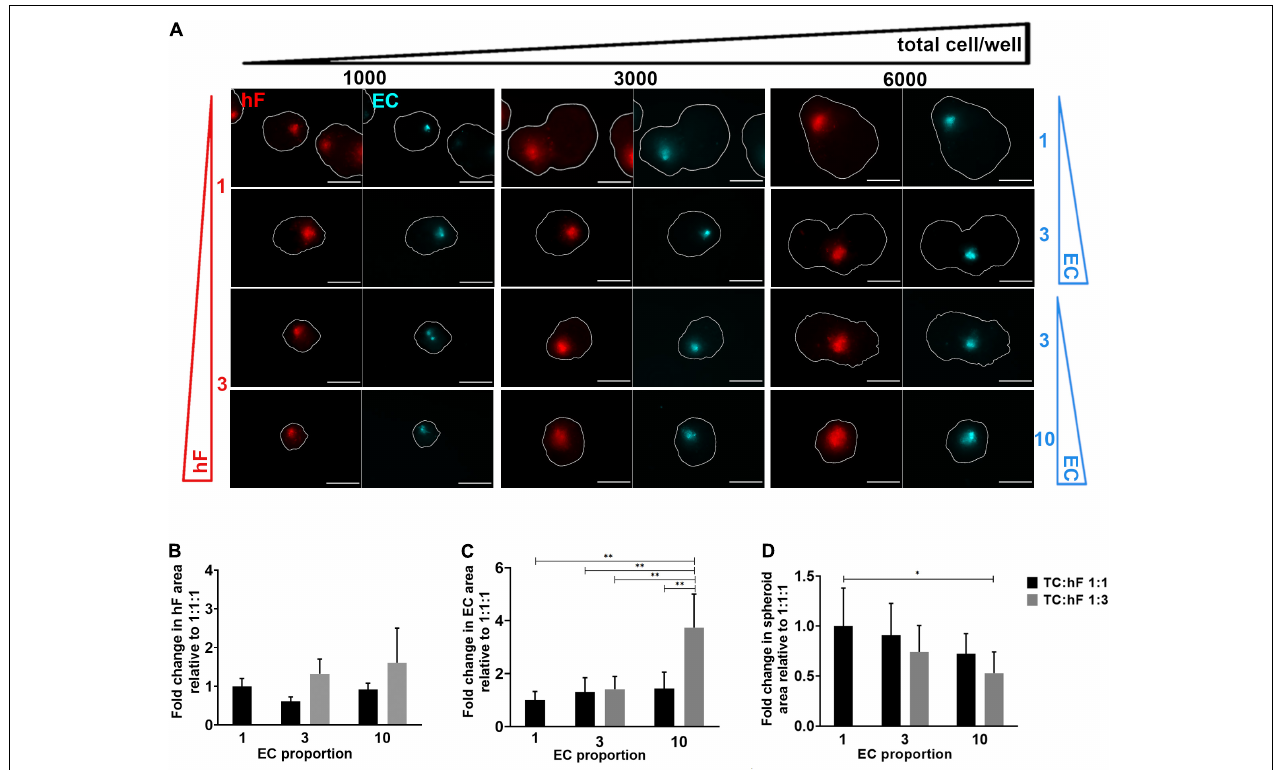
FIGURE 2 | Fibroblast and endothelial cell content in triple heterotypic spheroids: effect of total cell number and cell ratio. (A) Fluorescence microscopy of spheroids at day 30 of culture (after 2 days of static culture followed by 28 days of agitation-based culture). Spheroids of HCC1954 breast tumor cells (TC); human dermal fibroblasts, labeled with PKH26 (hF, red); HUVEC, labeled with CellTracker Deep Red (EC, cyan), seeded at the TC:hF:EC ratios and cells per well indicated. The spheroid outline at the equatorial axis is represented in a solid white line and was determined based on the FDA labeling of live cells ( Supplementary Figure 3A ). Images are representative of the 5–10 spheroids assessed per condition, in each of the three to four independent experiments performed. Scale bar, 250 µ m. Quantification of fold change in (B) hF area, (C) EC area, and (D) total spheroid area at the equatorial axis, for spheroids from A, seeded at 6,000 cells per well. The EC and hF areas were normalized for the total spheroid area at the equatorial axis; the fold change was determined relative to the condition with a TC:hF:EC of 1:1:1. Data are presented as mean ± SD from N = 3–4 (independent experiments); in each experiment, at least 20 spheroids were quantified per condition; statistical analysis was performed using a one-way ANOVA followed by a post hoc Tukey’s multiple-comparison test; ** p < 0.01, * p < 005.